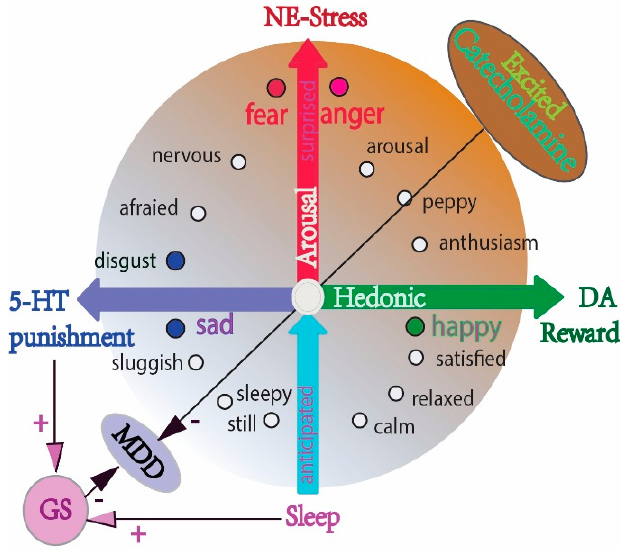
Figure 3. The different effects of monoamine on emotional arousal and sleep, on the glymphatic system and on MDD. The schema shows the relationship between monoamine and basic emotions (DA: reward, NE: stress, 5-HT: punishment) (modified from our previous paper [74,75]), and the two-dimensional model of emotions (valence and arousal). The major effects of 5-HT may be sedation and the inhibition of suicide ideation. Excessive catecholamine (DA and NE) antagonize the glymphatic system, while serotonin (5-HT) facilitates sleep and helps the glymphatic system with its housekeeping function. Chronic stress and induced excessive catecholamine release impair the glymphatic system, leading to ROS accumulation and MDD.